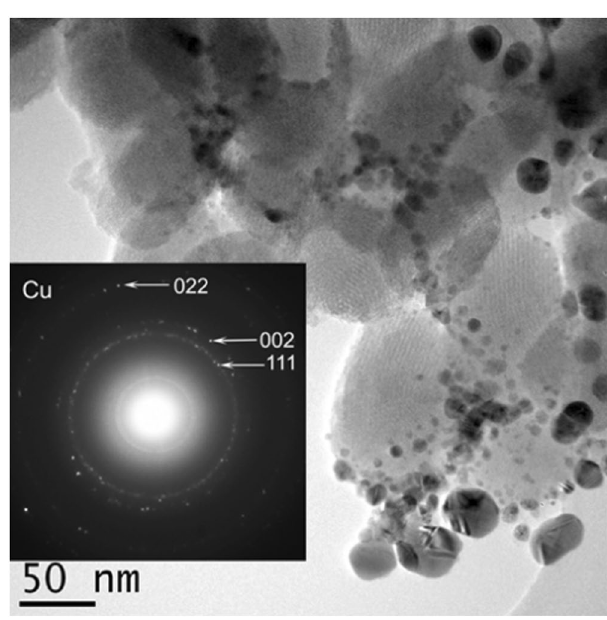
Figure 2. TEM images for CuNPs/SiO 2 catalyst and electron diffraction pattern